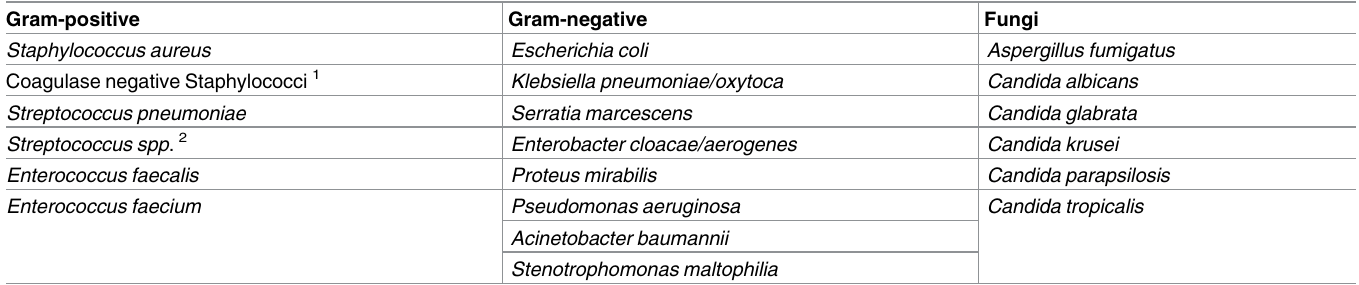
Table 2. SeptiFast MGRADE systempathogen